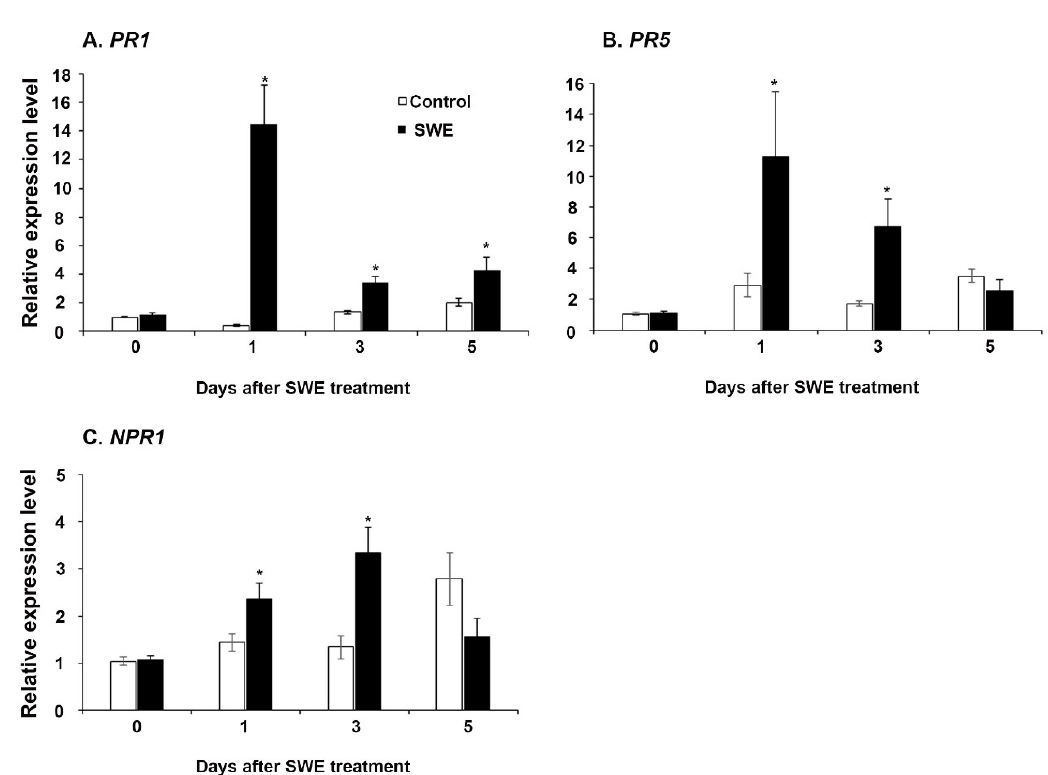
Figure 1. Relative quantification of the expression (fold change) of priming-related genes: ( A ) PR1 , ( B ) NPR1 , and ( C ) PR5 in A. thaliana at 0, 1, 3, and 5 days after a single application of SWE or water as the control. Data shown are the mean of three independent biological replicates (each replicate consisted of 10 plants) and bars represent the standard error of the mean. * denotes significant difference ( p = 0.05) between SWE and control samples at each time point according to Duncan’s multiple range test.